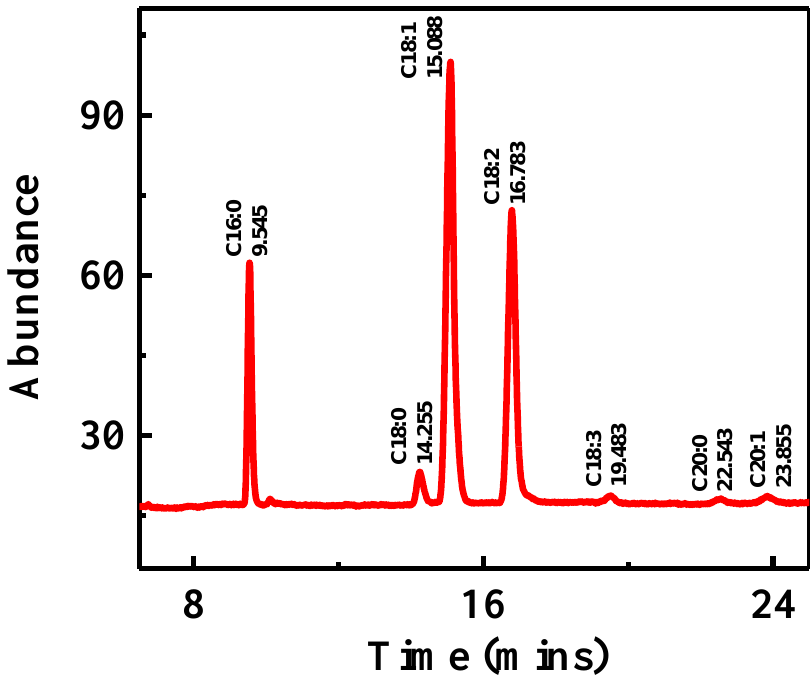
Figure 11. GC–MS analysis of fatty acid compositions of RT seed oil Biodiesel.